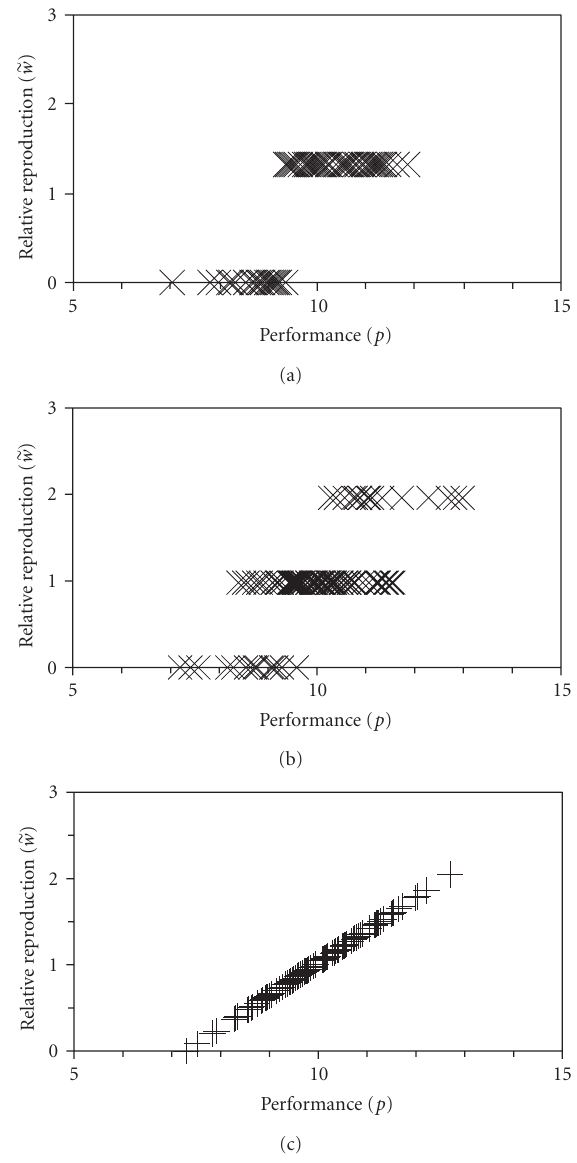
Figure 1: Three fitness functions illustrated using the same set of 100 simulated individuals with performance values drawn from a normal distribution with mean = 10 and standard deviation = 1. (a) threshold selection (b) stochastic proportionate selection (SPS), (c) deterministic proportionate selection (using (8)). Each mark represents one